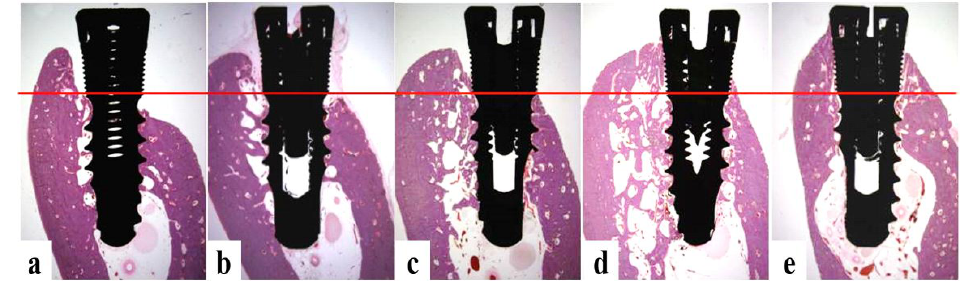
Figure 8. Histological specimens of the five groups. ( a ) Ti group; ( b ) Hepa/Ti group; ( c ) PDGF/Hepa/Ti group; ( d ) BMP/Hepa/Ti group; and ( e ) PDGF/BMP/Hepa/Ti group (×12.5 magnification). Note pronounced peri-implant bone re-modeling and vertical bone growth in the BMP/Hepa/Ti and PDGF/BMP/Hepa/Ti groups. Red lines indicate defect levels.